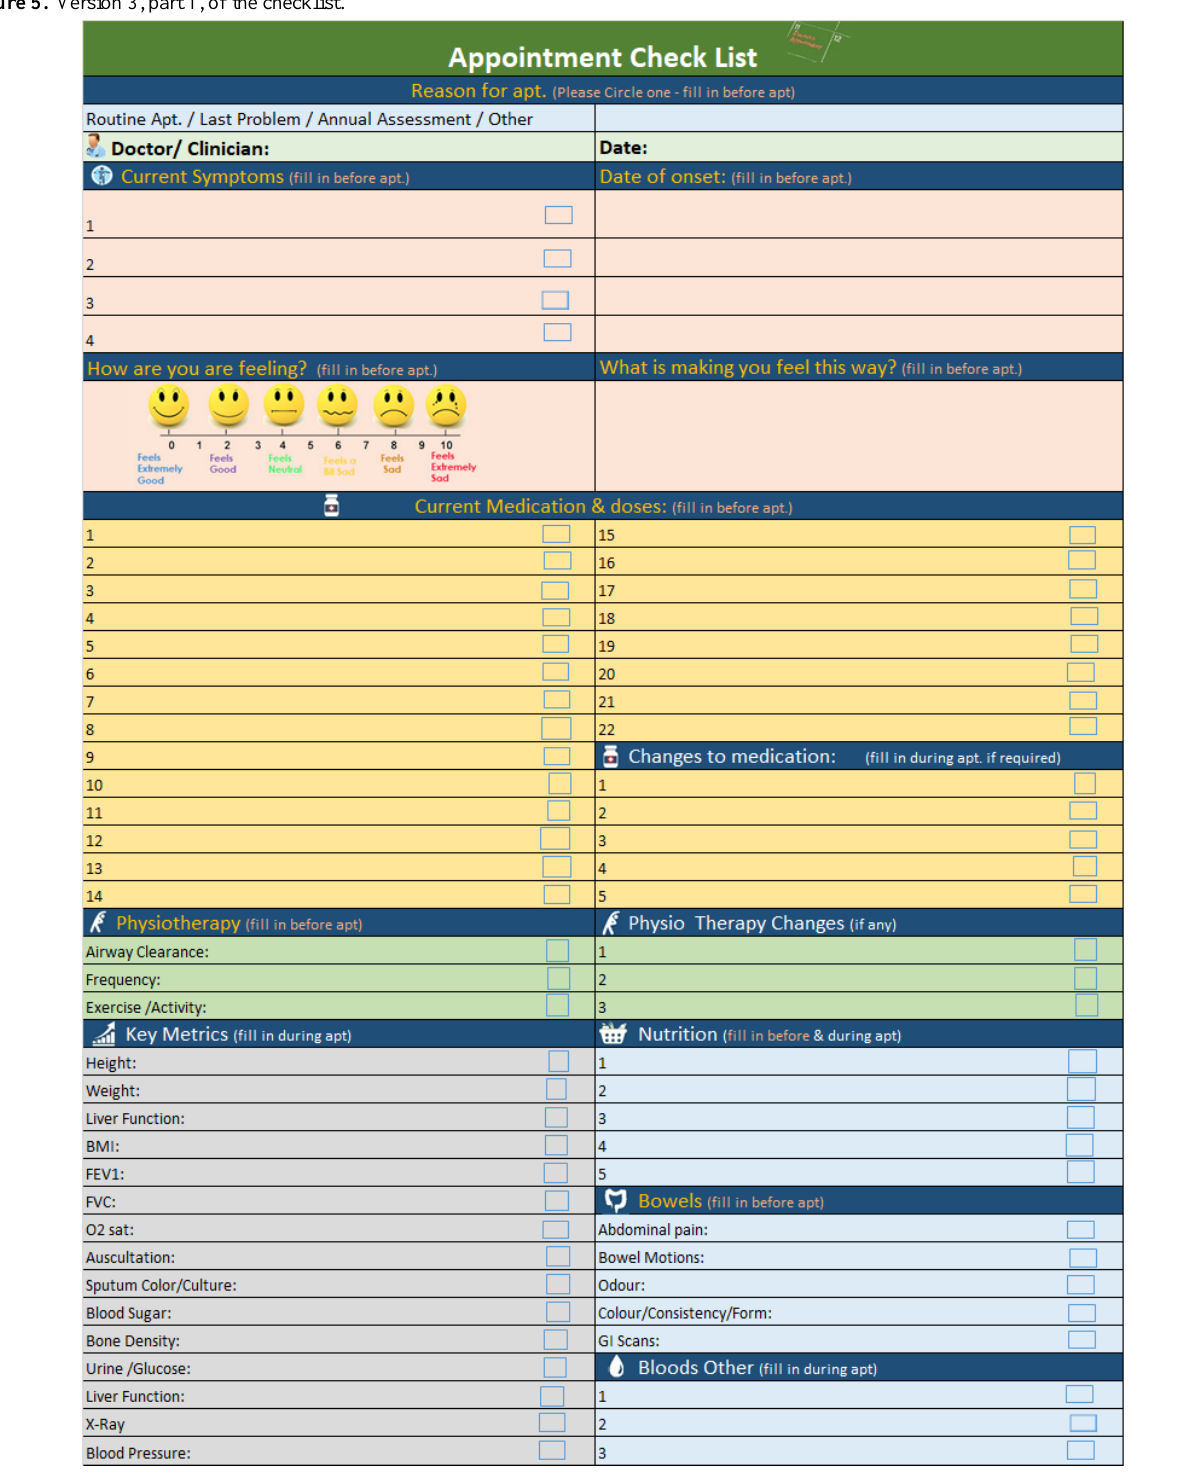
Figure 5. Version 3, part 1, of the